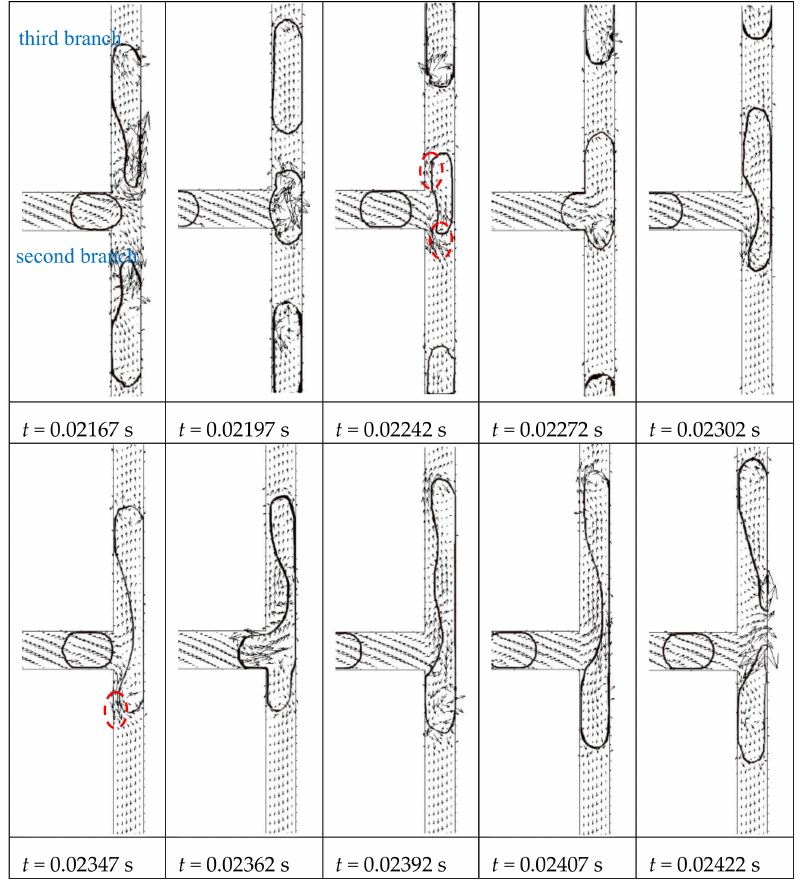
Figure 4. Bubble breakup at the third bifurcation of the fractal tree-shaped microchannel (Ca 0 =